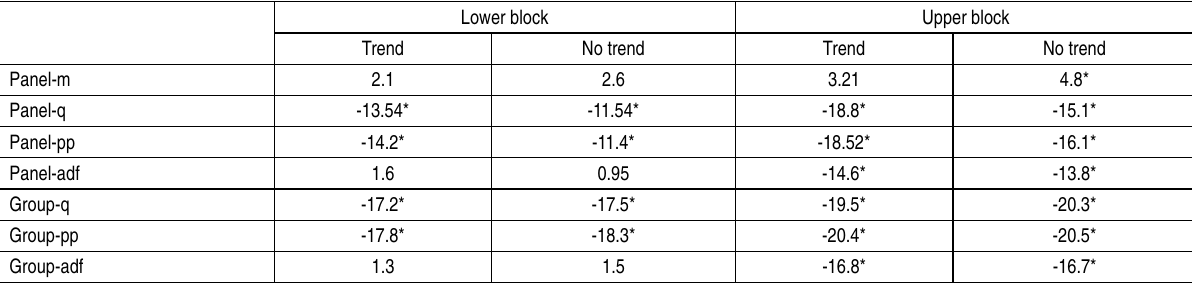
Table 5. Pedroni (1999) cointegration